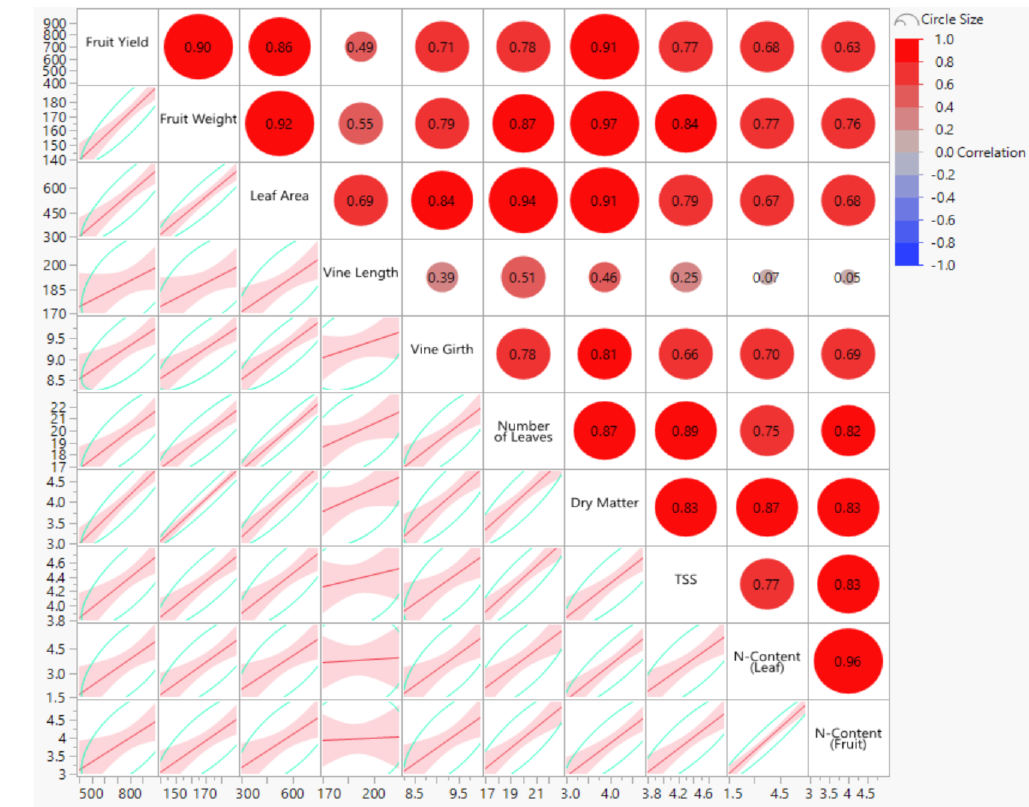
Figure 3. Scatterplot matrix for productivity—enhancing traits of cucumber under 4 treatments. The biplots of each trait with other traits showing significant relationships are presented at the lower side of the diagonal, while on the upper side, the correlation among traits under different treatments is displayed. Different shades of colors show different levels of correlation values and sizes of circles to represent the extent of correlation among these traits under